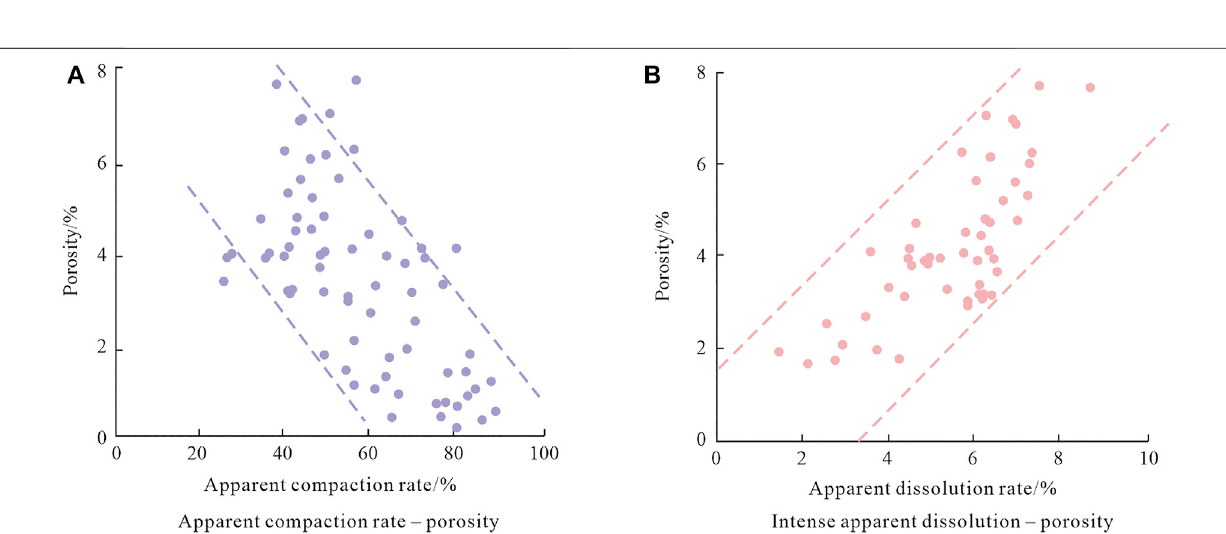
Frontiers in Earth Science |